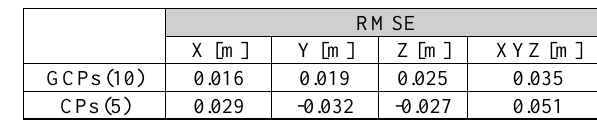
Table 5. Mean errors on GCPs and